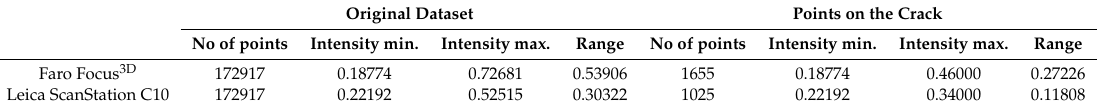
Figure 11. 2D crack mapping by segmentation. Table 4. Comparison of the point numbers of the original and segmented point clouds.